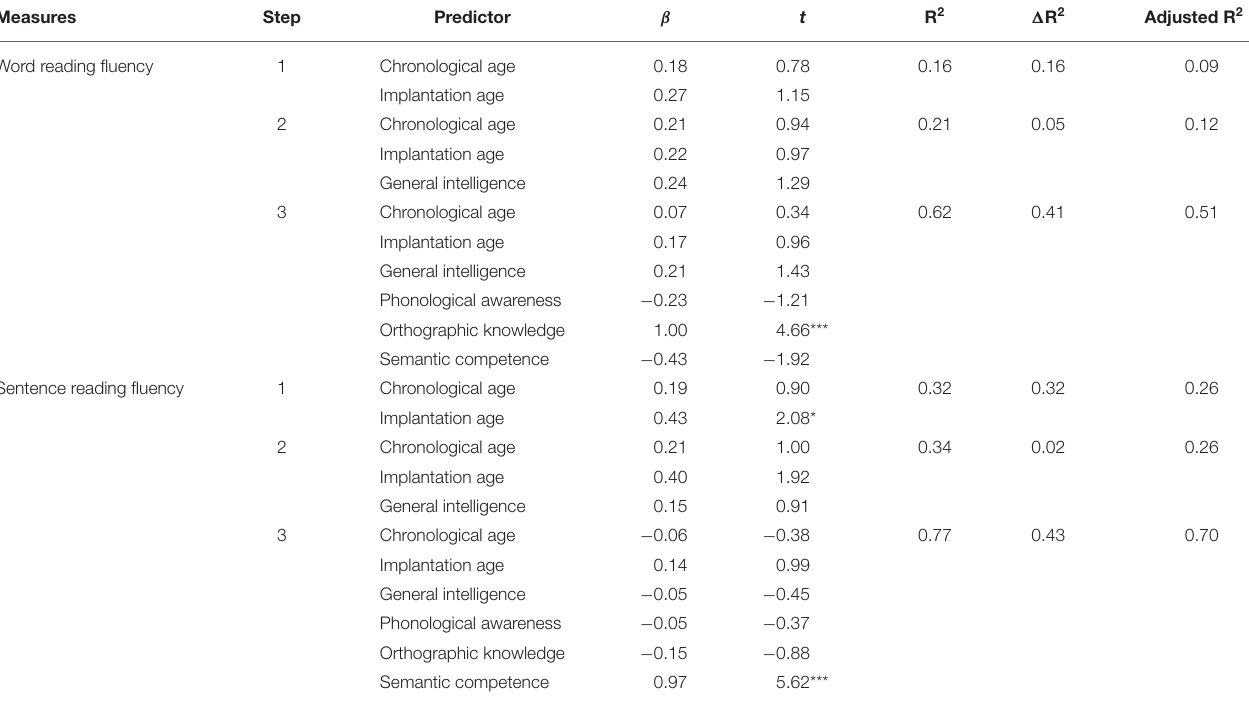
TABLE 3 | Hierarchical multiple regressions predicting word reading fluency and sentence reading fluency for children with HL.